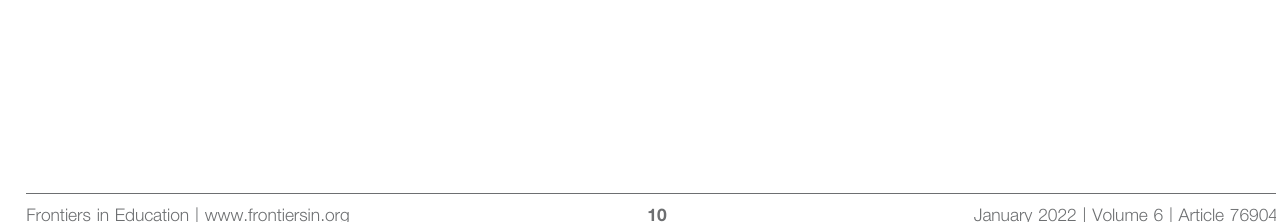
Frontiers in Education |